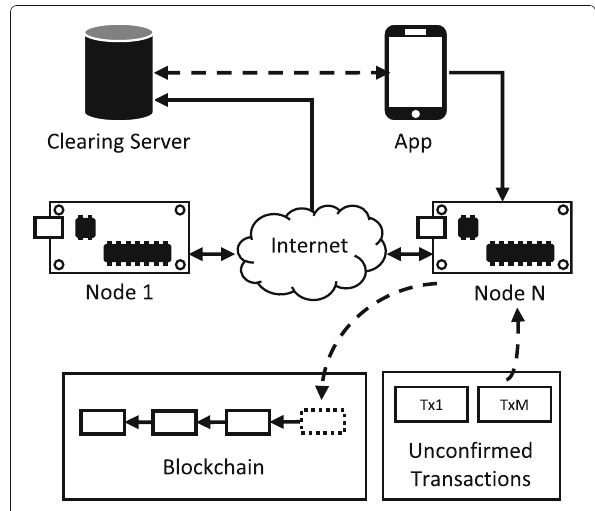
Fig. 1 Overview of the setup, including nodes, the clearing server, the app, and a conceptual view of the blockchain. Each customer possesses an app that is connected to a node (for sending new transactions and receiving confirmations) and to the clearing server (for billing). New transactions (denoted as Tx) reside in a pool of unconfirmed transactions until they are mined by a node and appended to the blockchain. The clearing server retrieves data from the blockchain and sends billing information to the customers’ smartphone